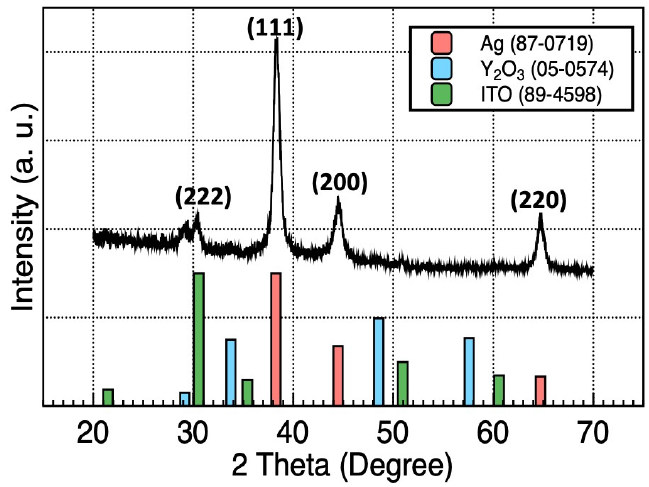
Figure 2. GIXRD spectra of Ag/Y 2 O 3 /ITO/Glass films.